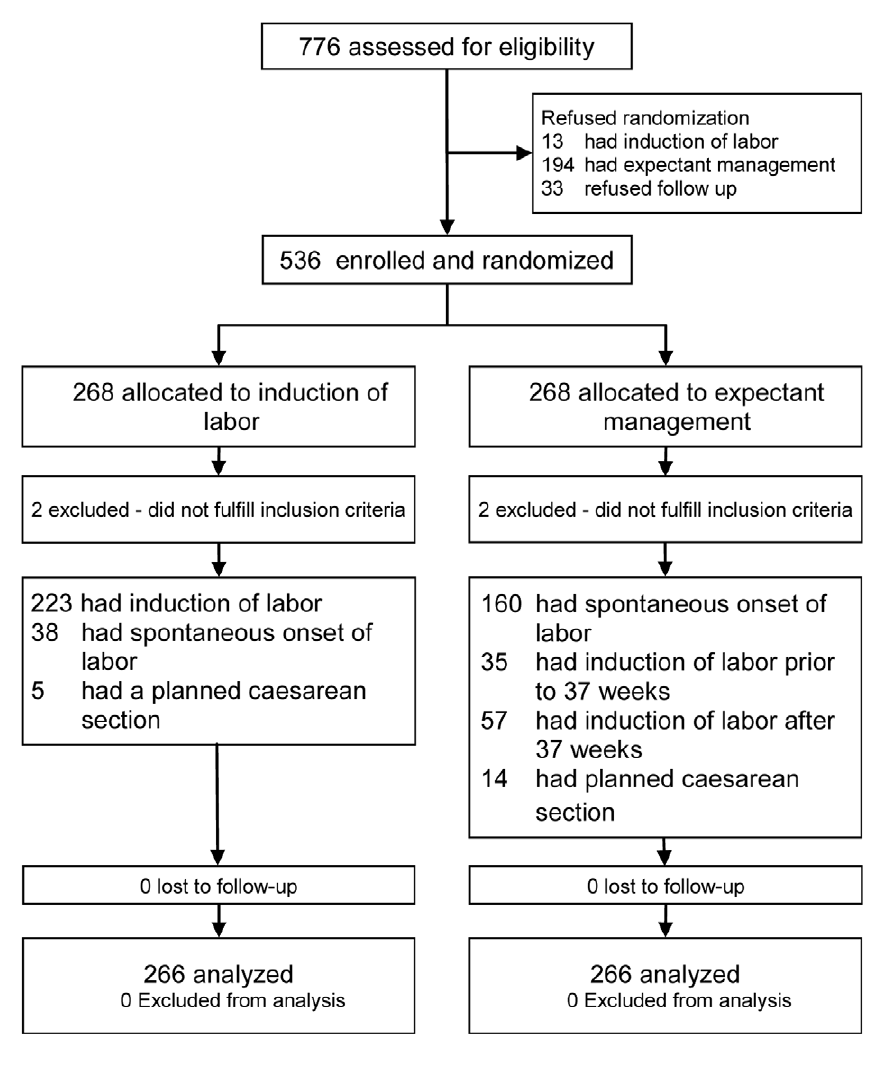
Figure 1. Trial profile.